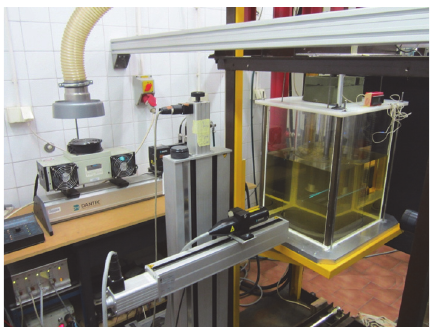
Figure 2: The LDA apparatus for the experimental